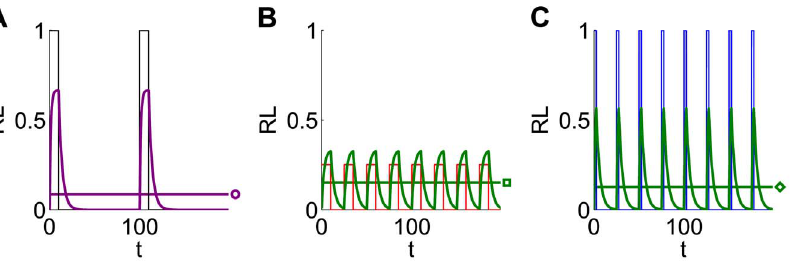
Figure 2. Responses of the ligand-receptor binding model to dose conserved input pulses. ( A ) An initial signal (black) elicits a response in the fraction of bound receptors (RL, purple) with mean value shown by a horizontal line and circle. The initial signal has A 0 =1 and d 0 =10 at frequency f 0 =0.01. ( B ) Responses to input signals with four times the initial frequency are shown in green, with input dose conservation by amplitude compensation (red). ( C ) As in (B), but with duration compensation (blue). The mean response in both (B) and (C) is increased compared to (A).